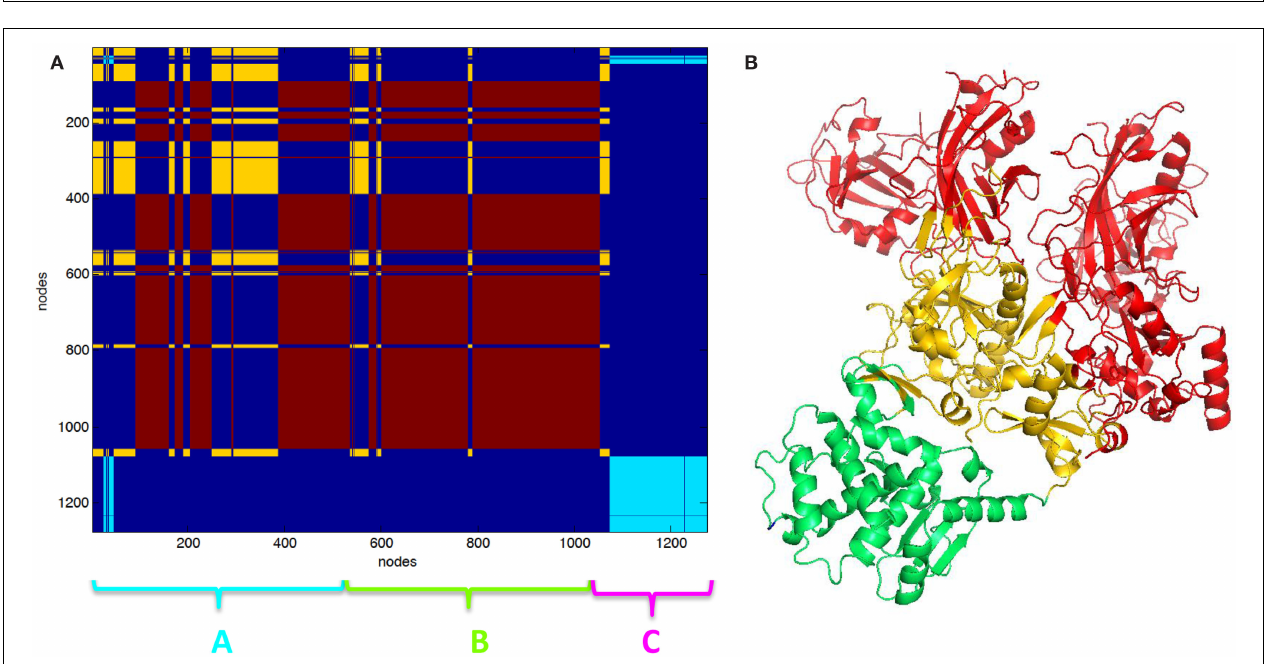
FIGURE 2 | Clustering partition of PA–PA–LF complex: (A) clustering color map, the length of the three chains is reported for reference; (B) cartoon representation of clusters the green cartoon corresponds to the light blue cluster in (A) . The lethal factor (LF) is highlighted by the empty circle.